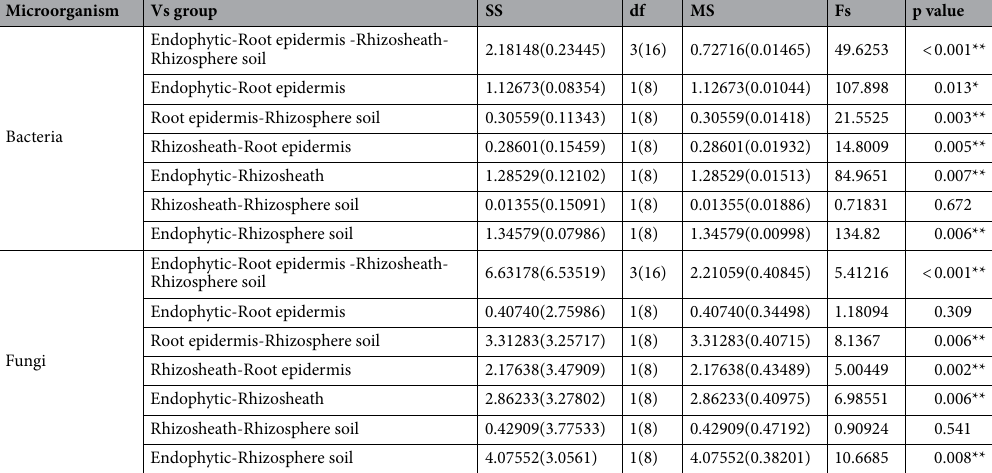
Table 2. AMOVA analysis significance test table of difference in bacterial and fungal community structure between groups. *Significant difference between groups ( p < 0.05); **Extremely significant difference between groups ( p < 0.01). SS stands for total variance, also known as the sum of squares of deviation; df is degrees of freedom; MS is the mean square (difference), i.e. SS / DF; FS is the F test value; p-value is the p value, with a value less than 0.05 indicating significant difference between groups. The values corresponding to the residual items are in